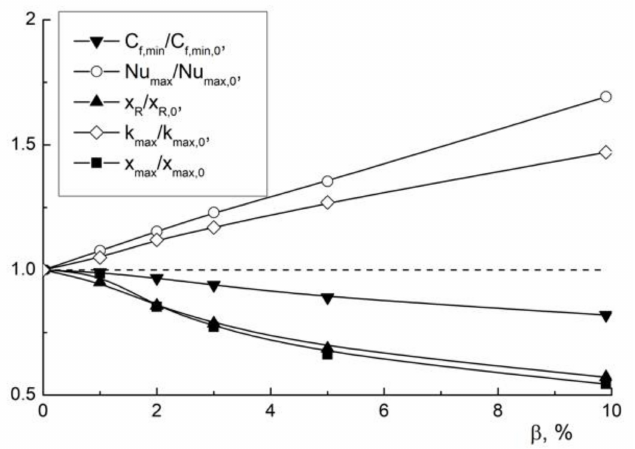
Figure 15. The magnitudes of minimal wall friction coefficient (1), maximal heat transfer enhancement ratios (2), recirculation length (3), maximal values of turbulence modification ratios (4) and position of heat transfer maximum (5) depending on gas volumetric flow rate ratios β . Re H = 6600, ER =